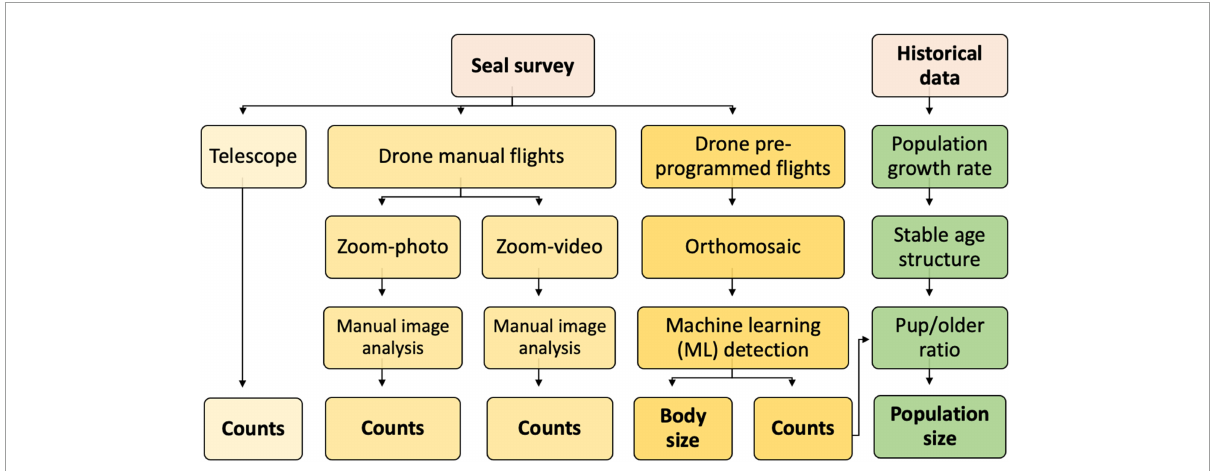
FIGURE1 Diagram of the survey methods and workflow tested in the study. Seal surveys were performed both with traditional observations by telescope, and by drones. Drone missions were either manually piloted, or pre-programmed. All methods resulted in estimates of the number of newborn pups, that in turn was evaluated in terms of “pup/older seals ratio” and evaluated in the light of total population size.